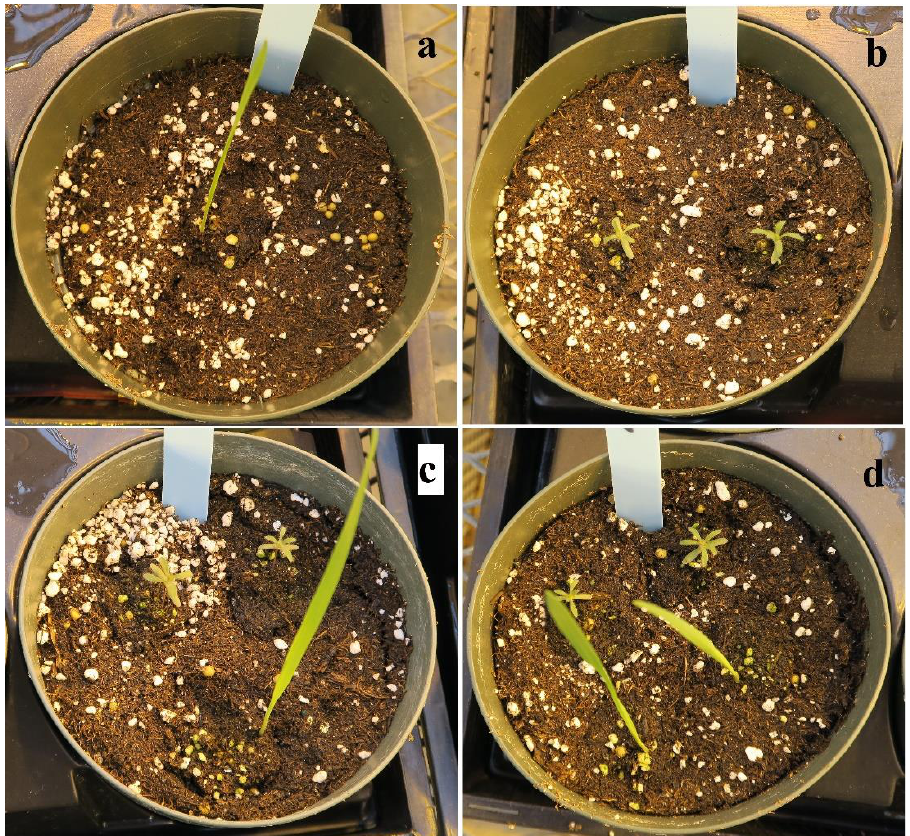
Figure 1. Example planting orientation for the wild oat ( Avena fatua ) and kochia ( Kochia scorpia ) competition experiments conducted in 2019 to 2020 in Saskatoon, SK. Treatment combinations resulted in ( a ) one plant per pot, ( b ) two plants per pot, ( c ) three plants per pot, or ( d ) four plants per pot. The pot tag is 1.5 cm in width.